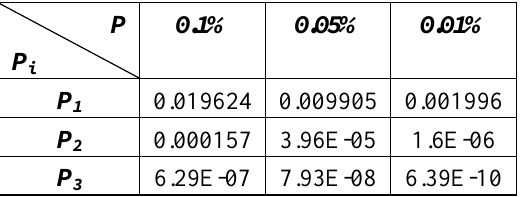
Table 1. Probability of i link failures: P